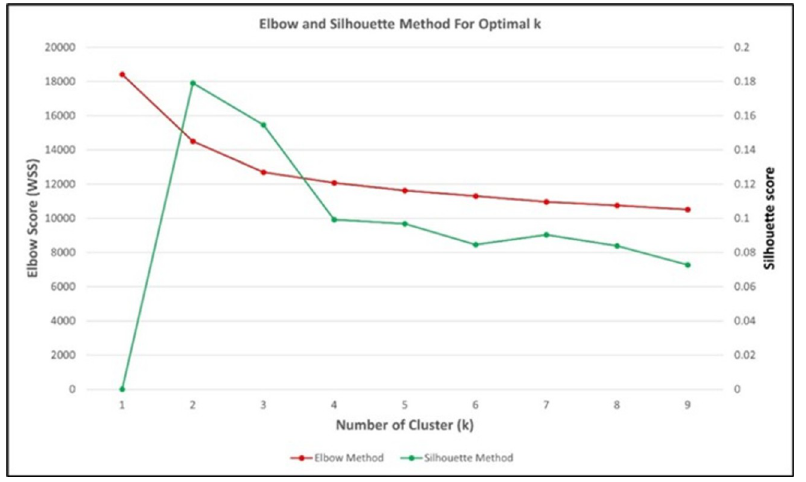
Fig 2. Cluster number determination technique based on the Elbow and Silhouette